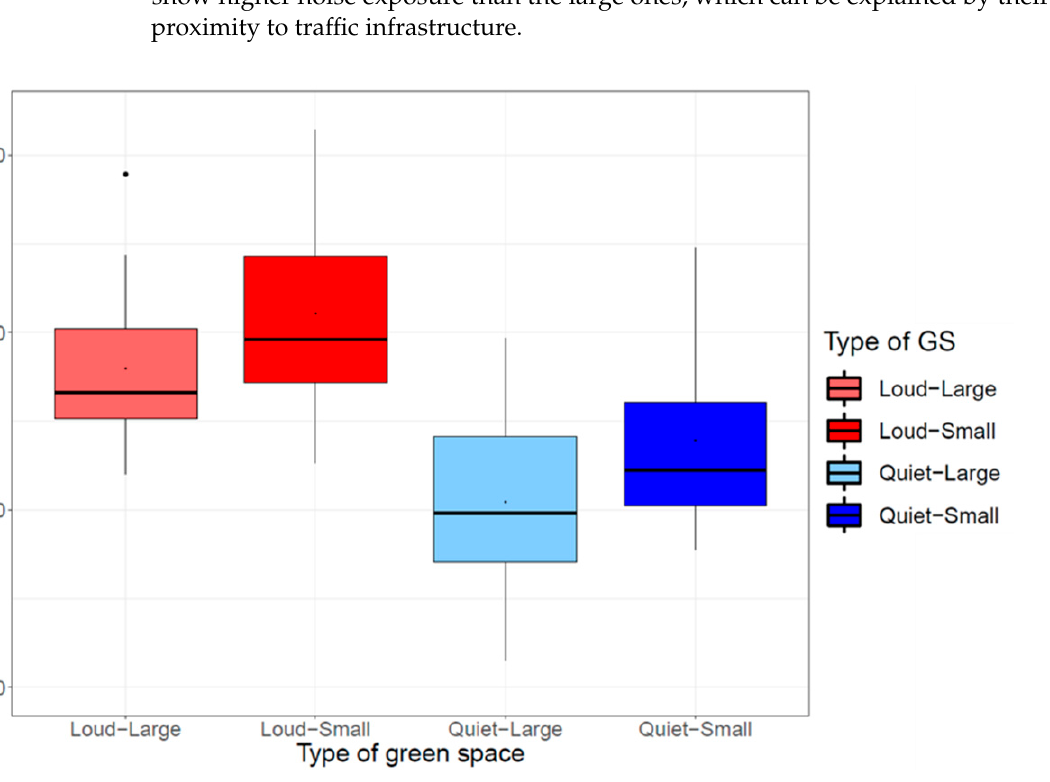
thus have nothing to measure). Both indicators discriminate the GSs assigned to the study groups well and in the expected order. The two groups LA and QuLa were those with the lowest N5 _ 10 ′ and L Aeq_10 ′ values. In addition, the study group LoSm had the highest N5 _ 10 ′ and L Aeq_10 ′ . Further, the two indicators N5 _ 10 ′ and L Aeq_10 ′ were highly correlated (Spearman R = 0.96, p < 0.0001).